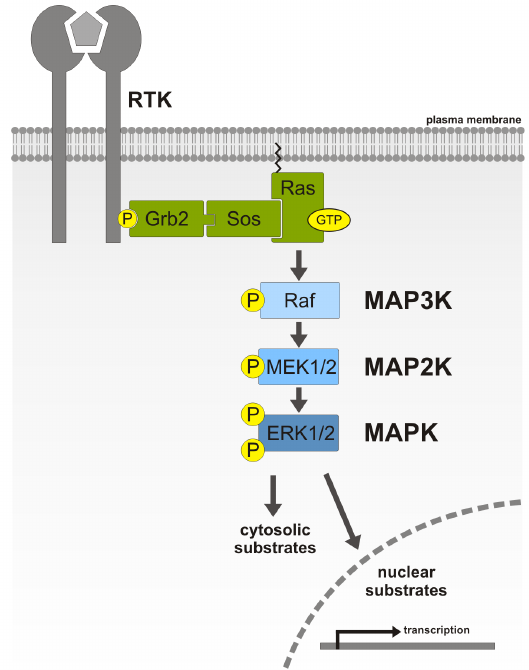
Figure 1. Schematic representation of the extracellular signal-regulated kinase (ERK)/mitogen-activated protein kinase (MAPK) cascade. Activation of receptor tyrosine kinases (RTK) results in recruitment of the adaptor, growth factor receptor-bound protein 2 (Grb2) and the guanine exchange factor (GEF), son of sevenless homologue (Sos), which then interacts with and activates Ras. This results in activation of C-Raf and, thereby, the initiation of sequential phosphorylation steps of the MAPK cascade. Activated ERK can phosphorylate either cytosolic or nuclear